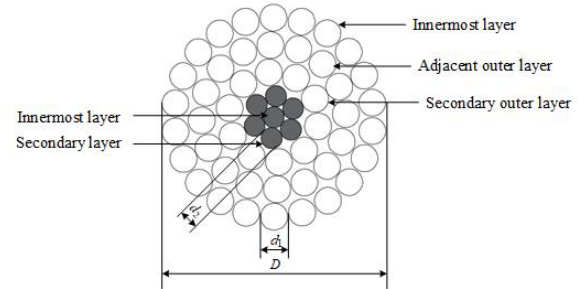
Fig. 4. Cross-section structure of catenary positive feeder